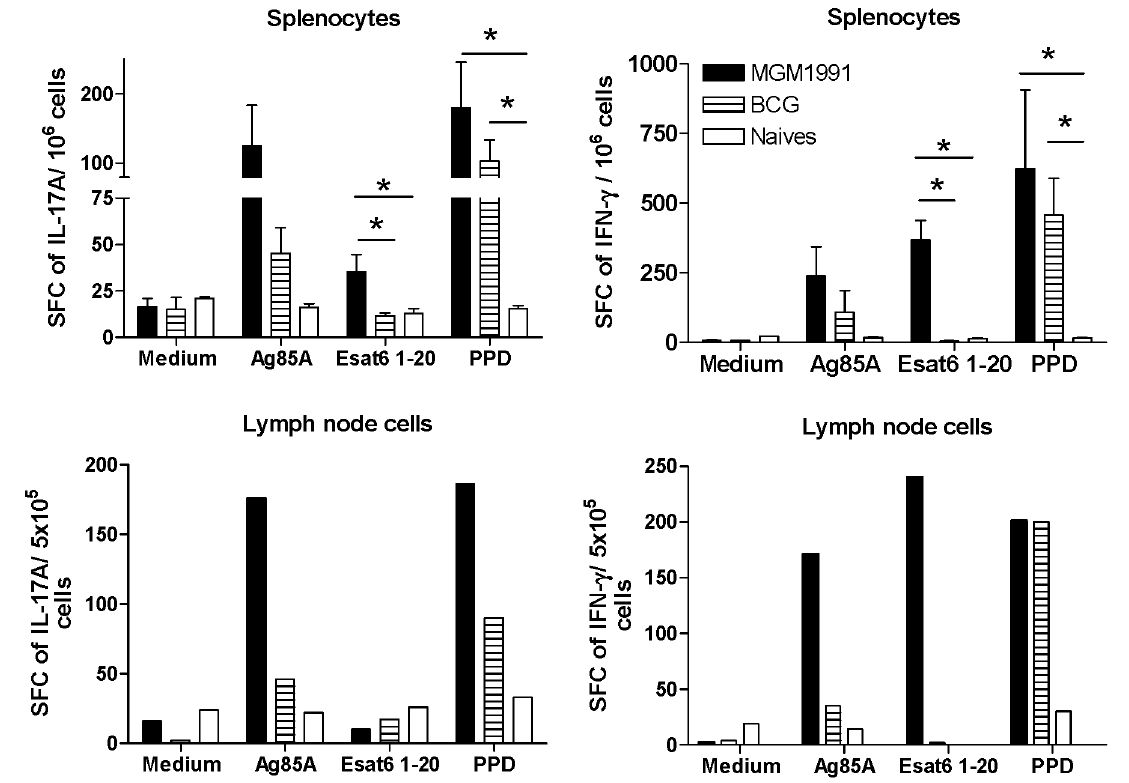
Figure 3. IFN-γ and IL-17A ELISPOT cells in spleen and draining lymph nodes of mice vaccinated with MGM1991 or BCG. IFN-γ and IL-17A producing cells in spleen and inguinal lymph nodes of C57BL/6 mice vaccinated 4 weeks before with 5x10 4 CFU of MGM1991 or M. bovis BCG by the subcutaneous route or from unvaccinated (naïve) mice and stimulated in vitro with recombinant Ag85A (5 µg/ml), with I-A b restricted immunodominant peptide spanning aa 1-20 of ESAT-6 or with purified protein derivative PPD from M.tb (10 µg/ml). Cytokine levels are expressed as mean number of spot forming cells/ 10 6 spleen cells (5 mice tested individually) or as mean number of spot forming cells/ 5x10 5 lymph node cells (pooled cells from 5 animals/group). * p < 0.05 (Mann-Whitney